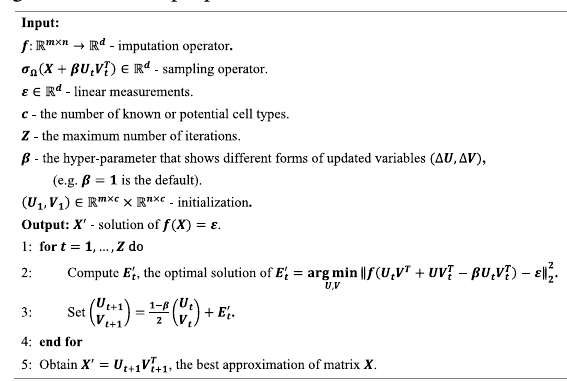
Algorithm 1. The proposed scGNGI